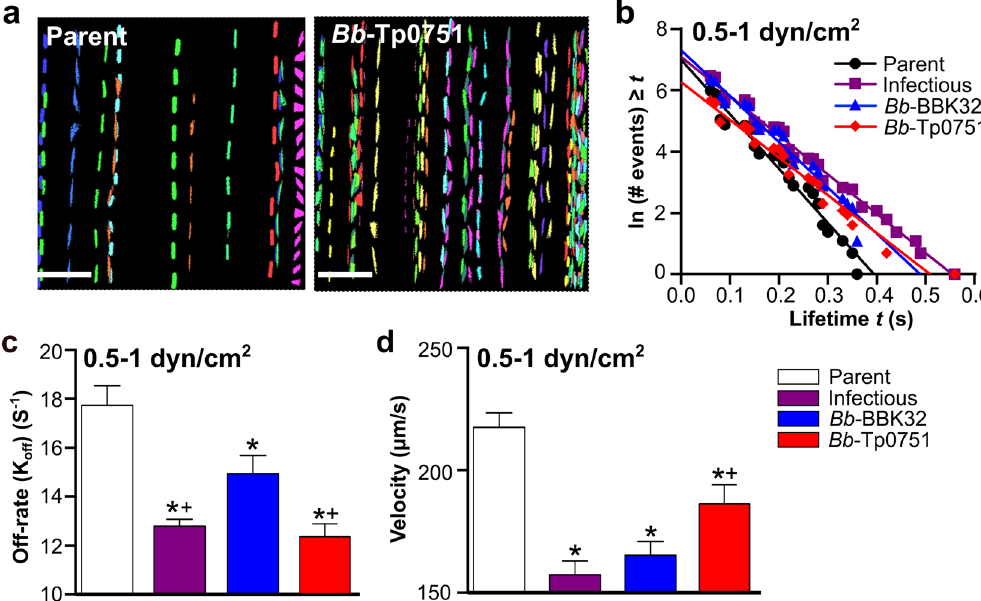
Figure 2. Bond dissociation rates and interaction velocities of Tp0751-expressing B . burgdorferi . B . burgdorferi interactions with HUVEC in flow chambers at 0.5 and 1 dyn/cm 2 were captured by particle tracking of interaction trajectories (tracks) in time lapse sequences. ( a ) Sample time lapse projections depicting interaction tracks of individual bacteria (1 color/bacterium) captured at 1 dyn/cm 2 over 2 min. Scale bars: 38 µ m. ( b ) The linear regression of the log-transformed number of interactions versus the lifetime (seconds) of the spirochete for 4 representative tracks (1 track for each of the 4 strains). The negative slope of each regression was an estimate of the dissociation rate (K off ) of the spirochete, as described in the Materials and Methods. ( c ) Mean ± SEM dissociation rates (K off /off-rates) for individual load-bearing adhesion complexes mediating bacterial-endothelial interactions under flow. ( d ) Velocities of interacting bacteria (mean ± 95% CI). In ( b – d ), bond dissociation rates and interaction velocities were calculated from interactions obtained at both 0.5 and 1 dyn/cm 2 . N = 4 and N = 8 independent flow chamber experiments for each strain at 0.5 and 1 dyn/ cm 2 , respectively. Eight replicate experiments were conducted at 1 dyn/cm 2 to obtain sufficient interaction numbers for tracking. Strains: Negative control strain: BBK32-deficient non-infectious adhesion-attenuated B31-A-derived strain (Parent; GCB706: Supplementary Table S1). Positive control strains: Parent expressing B . burgdorferi vascular adhesin BBK32 ( Bb -BBK32); BBK32-expressing B31-derived infectious strain (Infectious; GCB726: Supplementary Table S1). Bb -Tp0751: Parent expressing Tp0751. Numbers of interactions analyzed/ strain: Parent (408), Infectious (647), Bb -BBK32 (578), and Bb -Tp0751 (288). R 2 values for linear regressions in ( b ): > 0.9. Statistics: one-way ANOVA with Holm-Sidak post-tests ( c ), one-way Kruskal-Wallis ANOVA with Dunn’s post-tests ( d ). * Indicates p < 0.05 vs parent. + Indicates p < 0.05 vs Bb